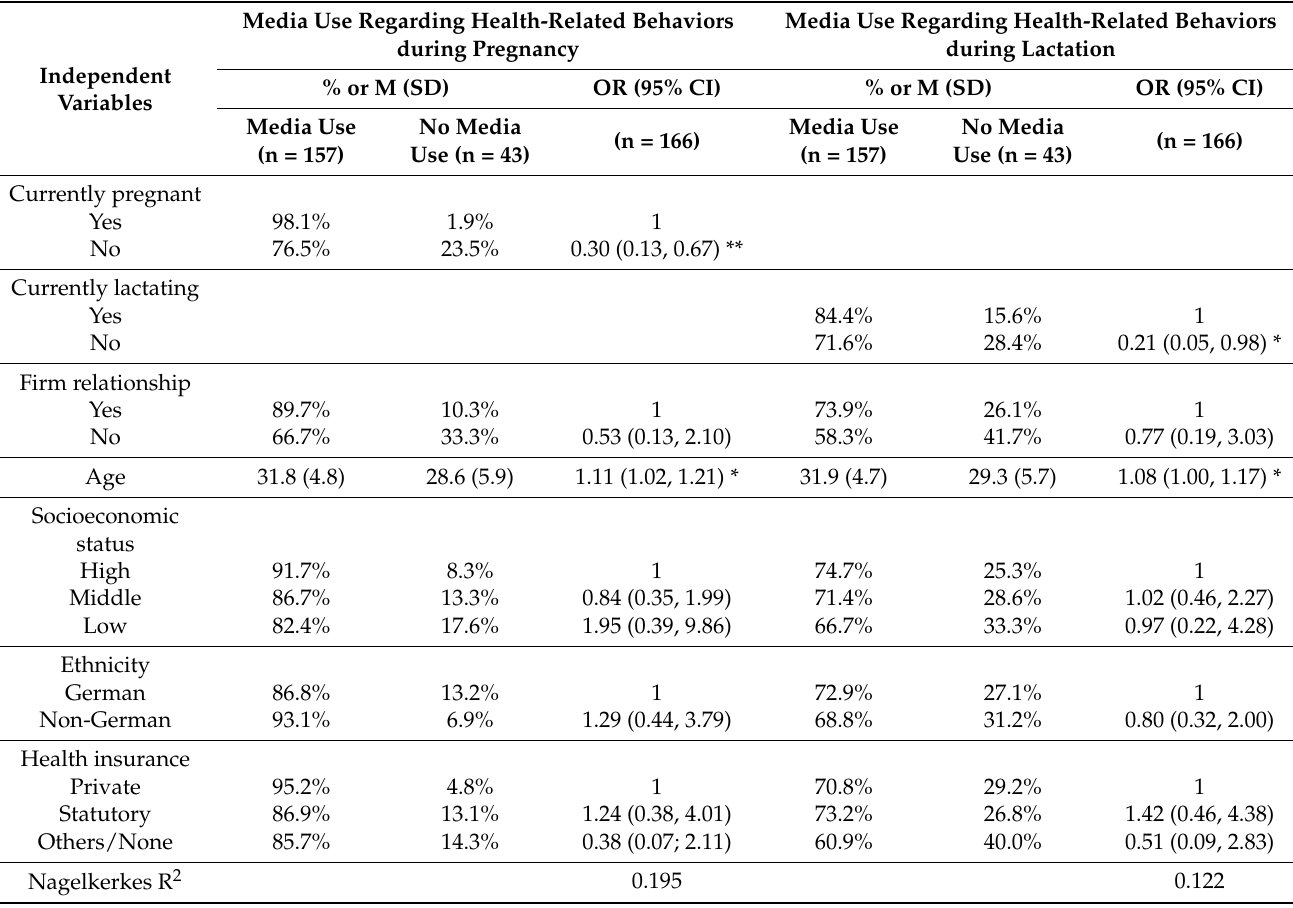
Table 2. Media use regarding health-related behaviors during pregnancy and lactation and its association with independent variables, expressed in odds ratios (95% confidence